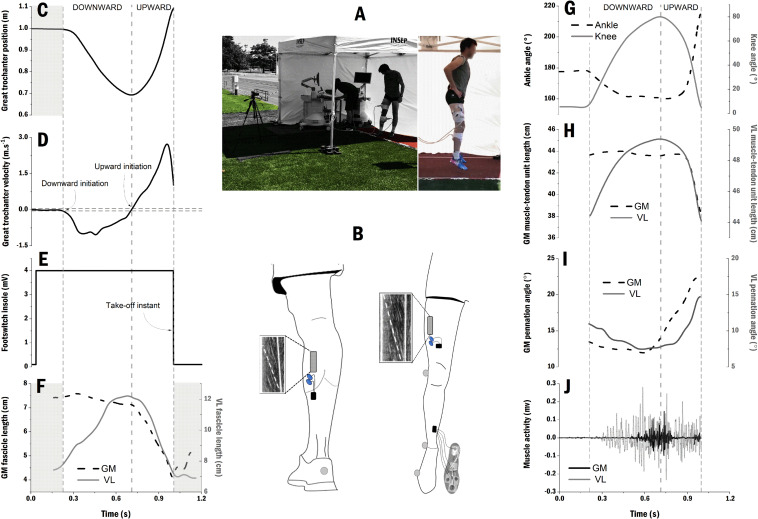
Representative data of one participant and processing overview. (A) Experimental setup outdoor under a tent which was moved along the protocol over the three surfaces (i.e., hybrid turf, synthetic turf, and athletic track); (B) Positions of the probes and electrodes over the gastrocnemius medialis (GM) and vastus lateralis (VL) muscle bellies, and the four force resistor sensors which were placed on the insole of the right shoe to detect take-off instant; Great trochanter position (C) and velocity (D) with downward and upward initiation instants; (E) Force resistor sensor pattern with 4 mV corresponding to a contact between the foot and the ground and 0 mv corresponding to flight period; (F) GM fascicle length (dash-black line) and VL fascicle length (gray line). The shaded areas correspond to the delimitation of countermovement jump; (G) Ankle (dash-black line) and knee (gray line) joint angles; (H) GM (dash-black line) and VL (gray line) muscle-tendon units length computed over the countermovement jumps; (I) GM (dash-black line) and VL (gray line) pennation angle; (J) Raw muscle activity of GM (black) and VL (gray) muscles before processing and normalization procedure (see section “Materials and Methods”).